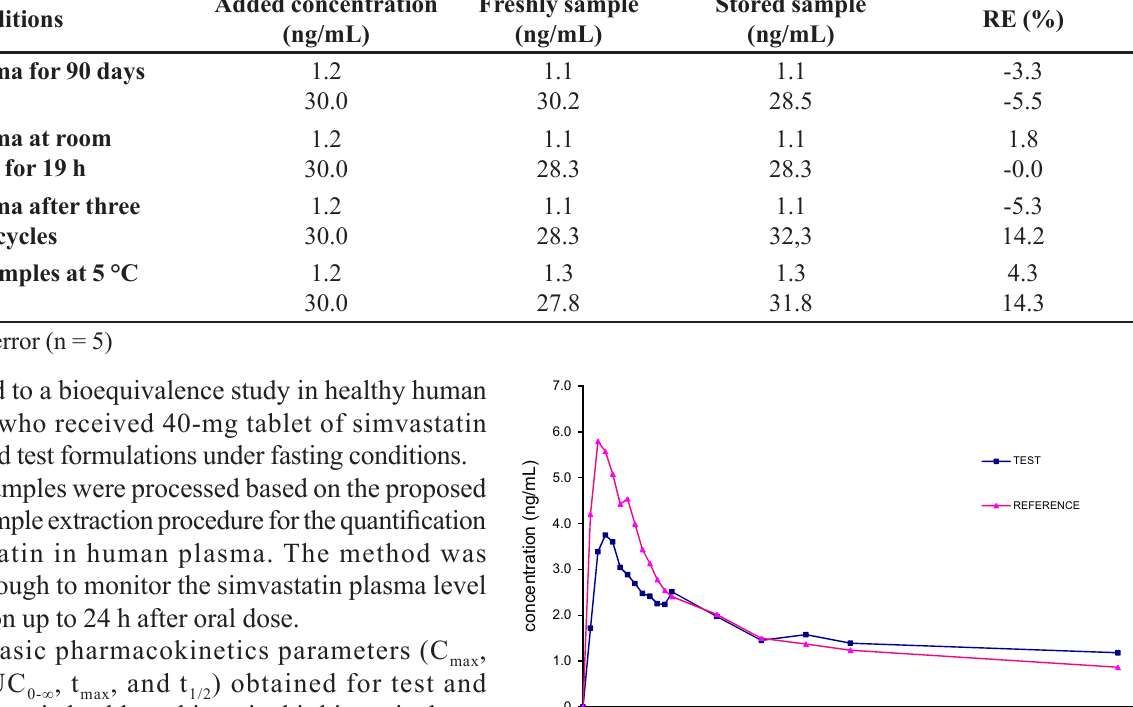
: time to peak concentration; t max